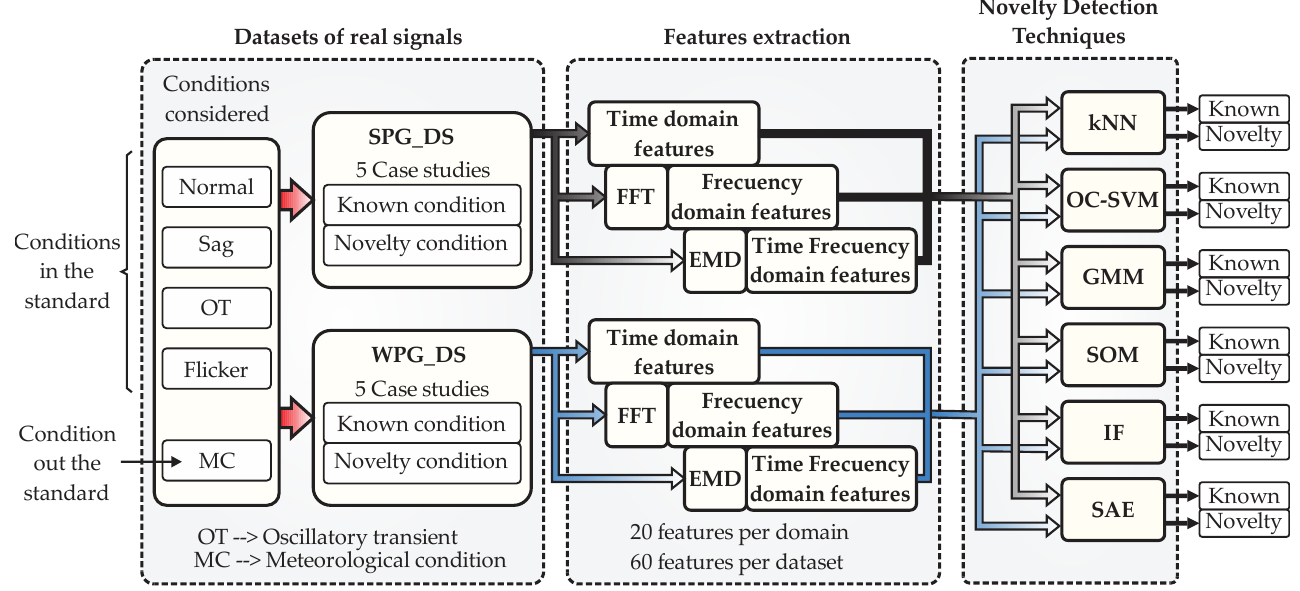
Figure 3. General block diagram of the methodology for implementing the techniques of ND.